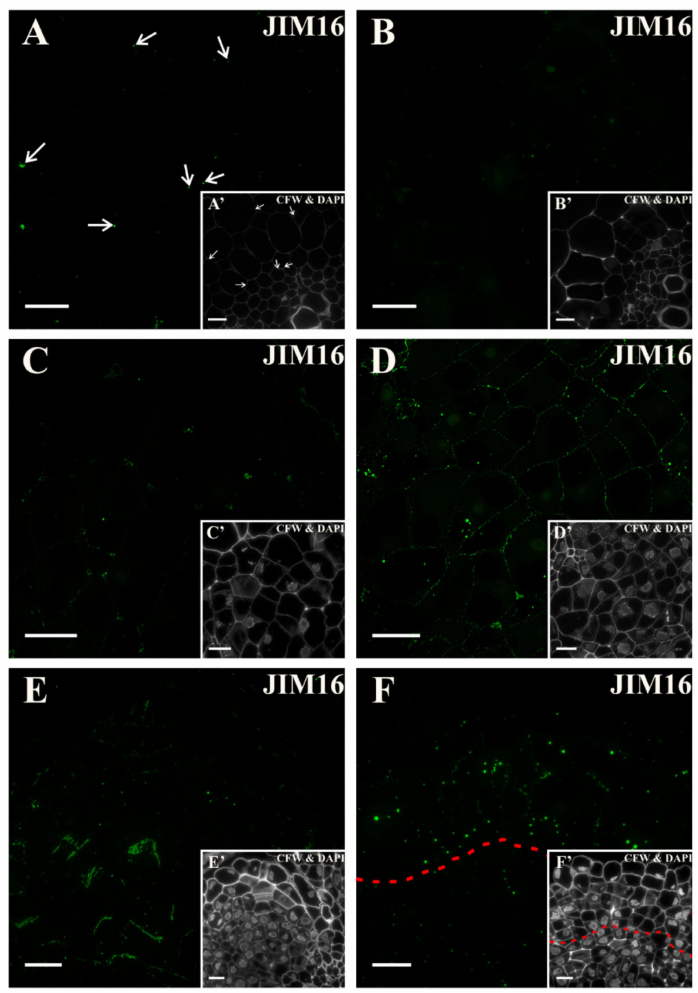
Figure 9. Distribution of the AGP epitope that is detected by the JIM16 antibody. ( A ) At the beginning of the culture, the signal was absent, except for a few punctate signals in some cells (arrows). ( B , C ) During the next days, the punctate signal was rarely observed ( B -second day of the culture; C -after four days). ( D ) After five days of the culture, signal was detected mainly in the walls of the dividing cells. ( E ) Along with increasing the duration of the culture, the signal disappearance in the dividing cells was noticed. ( F ) At the end of the culture, the punctate signal was detected mostly in the cells of the surface layers of explant (area separated by a dashed line). ( E’ , F’ ) Calcofluor white (CFW) and DAPI staining of the section shown on E , F . Scale bars: A – F , E’ , F’ —10 µ